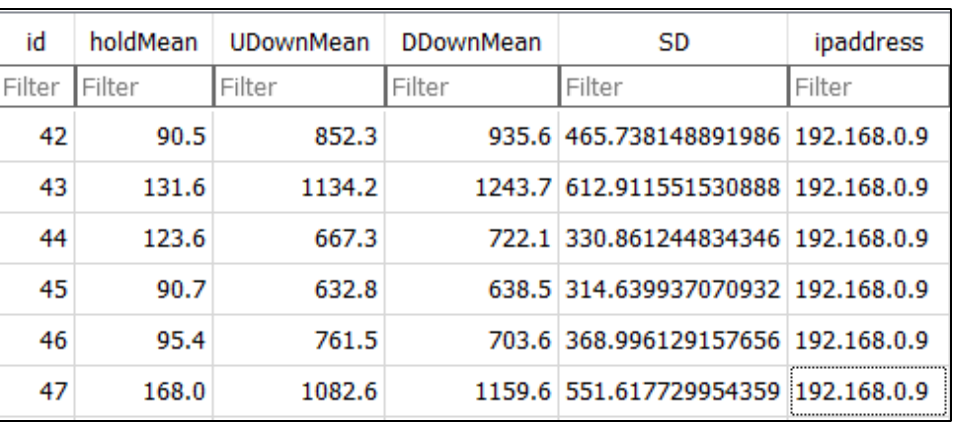
Figure 7. Time vector of one genuine user .